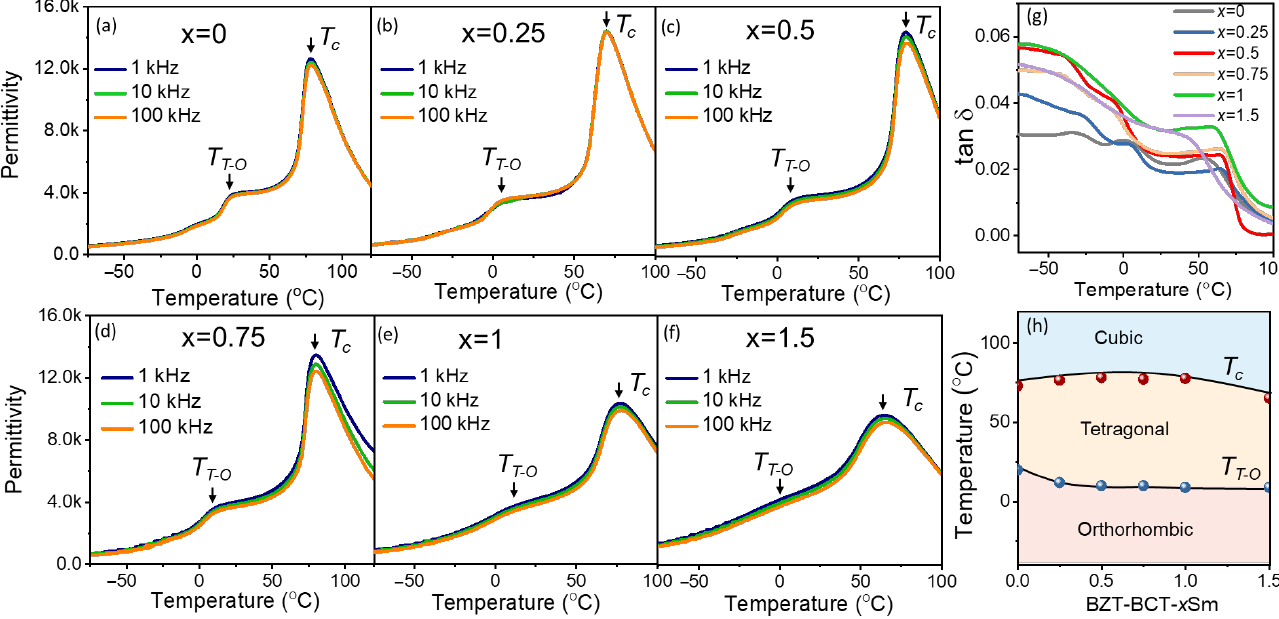
Figure 2. ( a – f ) Temperature-dependent permittivity of the BCZT- x Sm ceramics at different frequen- cies (1 kHz, 10 kHz, and 100 kHz), where x = 0, 0.25, 0.5, 0.75, 1, and 1.5, respectively; ( g ) the dielectric loss at 100 kHz and ( h ) corresponding temperature composition phase diagram showing the Curie temperature ( T C ) and the phase transition temperature ( T T-O ) from the tetragonal phase to the ortho- rhombic phase.